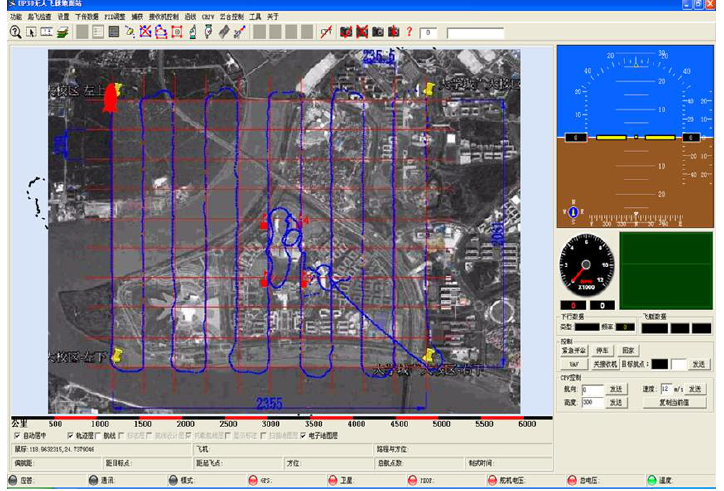
Figure 5. The human-machine interface system (HMI) and the airship’s predefined (red lines) and practical (blue lines) cruising